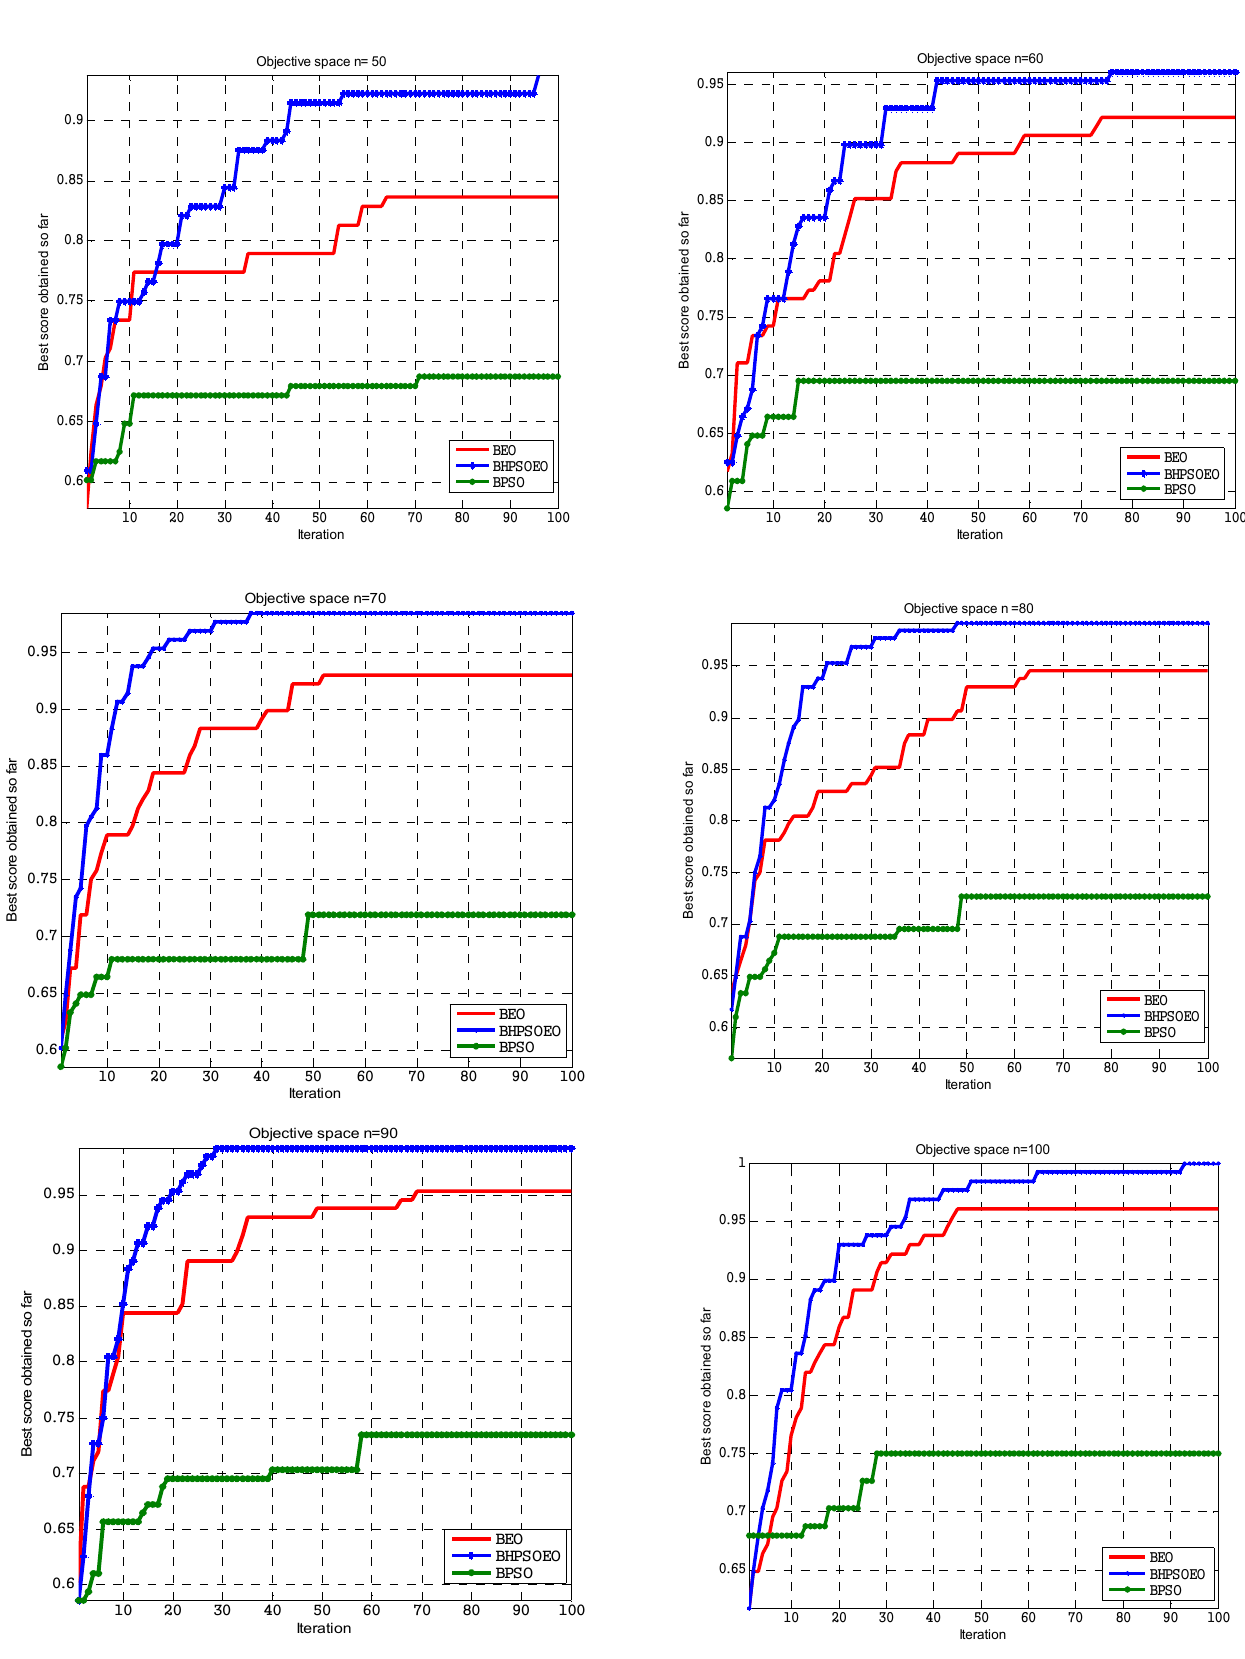
Figure 8. Convergence curve of BHPSOEO, BPSO and BEO for cryptanalysis of RC4 cipher with TextLen = 128 bits for different population sizes.